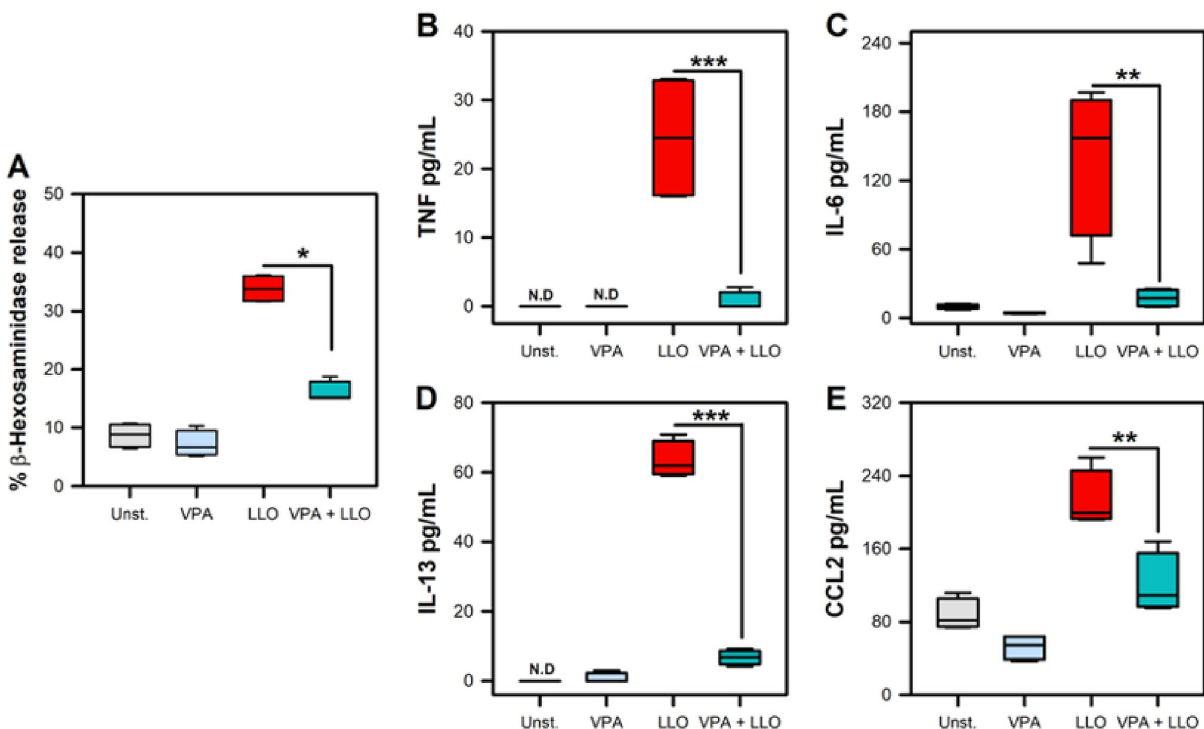
Figure 3. Valproic acid reduces mast cell cytokine production in response to Listeriolysin O. ( A ) BMMC were pre-incubated with 2 mM VPA for 18 h and then stimulated with Listeriolysin O (LLO) for 90 min. The MC degranulation percentage was determined by the β-hexosaminidase release assay. (n = 4 per group; * p < 0.05; Kruskal–Wallis test). ( B - E ) BMMC were pre-incubated with 2 mM VPA for 18 h and then stimulated with Listeriolysin O (LLO) for 24 h. Cytokines levels were evaluated in culture supernatants by ELISA. ( B ) TNF, (C) IL-6, ( D ) IL-13 , ( E ) CCL2. (n = 4 per group; N.D = Not Detected; ** p < 0.01, *** p < 0.001; Kruskal–Wallis